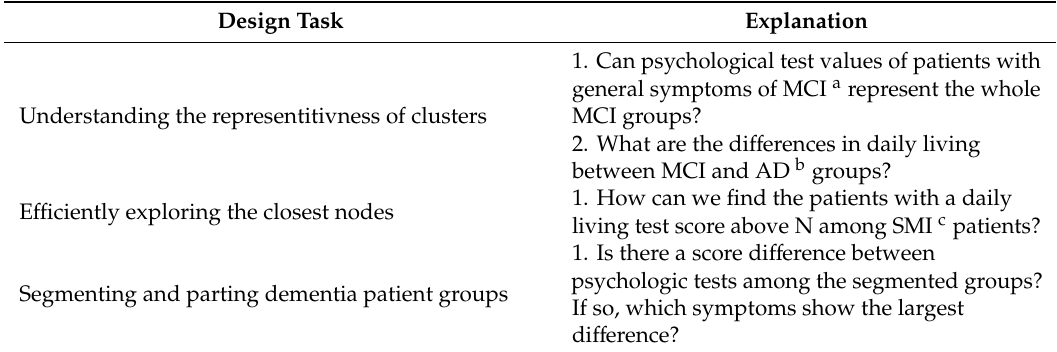
Table 1. System design guideline.